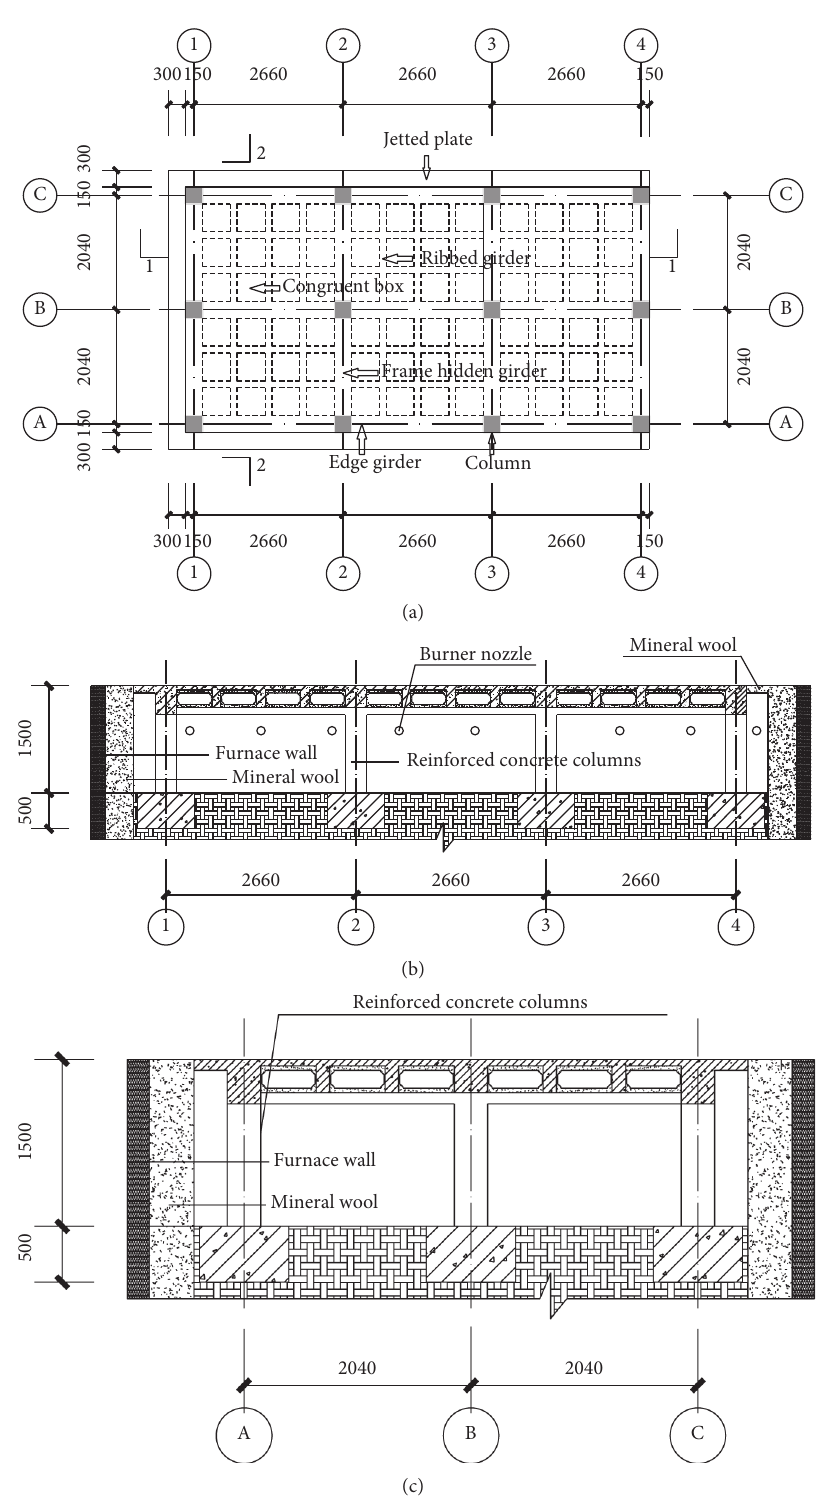
Figure 2: Plan view and front elevation view of the furnace. (a) Plan view of the continuous AMH slabs: (b) section 1-1; (c) section